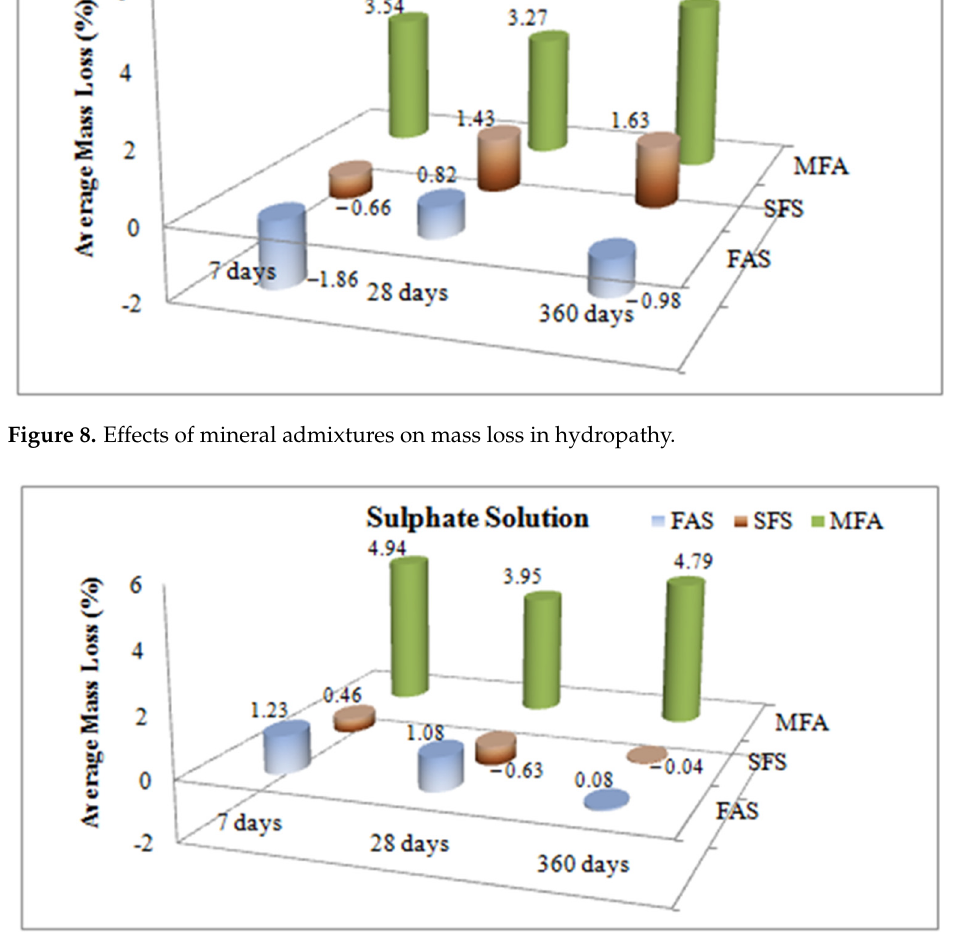
Figure 10. Plain concrete (MFA), silica fume (SFS) and fly ash (FAS) mineral additives substituted bar samples with curing conditions in hydropath and sulphate solution. The effects of alkali-silica reactions were observed by SEM in the hydropath samples after curing for 90 days, as shown in Figures 11–13. It is noted that for all of the cases no cracks at the bar samples that create volumetric expansion due to alkali-silica reactions were observed.